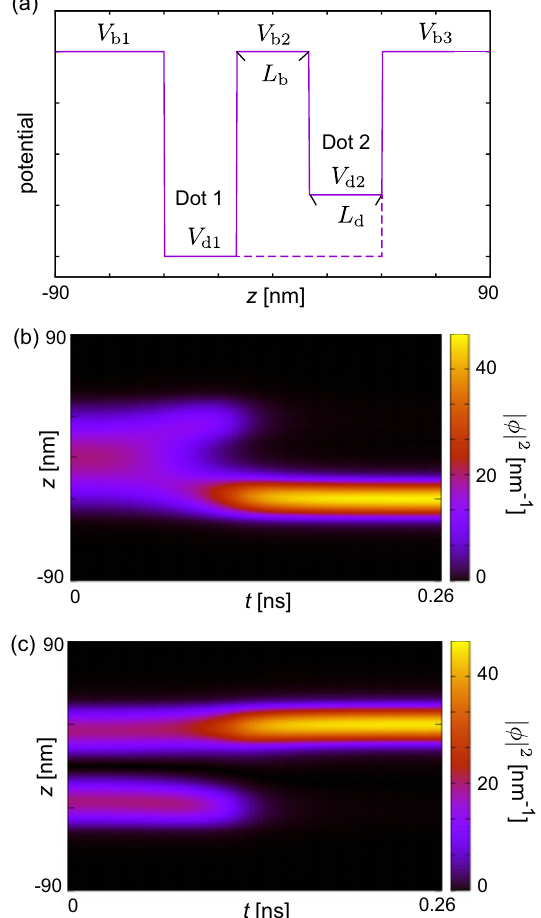
Figure 3. ( a ) Schematics of Dot 1 and Dot 2 in a one-dimensional model. V b i and V d j are the heights of the potential barriers and the depths of the potential wells, respectively. In this panel the difference in V d j is exaggerated for purpose of illustration. The dashed line shows the potential profile at t = T stepI . The time-evolution of the squared amplitude of the wave functions with initial states | 1, ↑(cid:105) ( b ) and | 2, ↑(cid:105) ( c ). The parameter set used was L